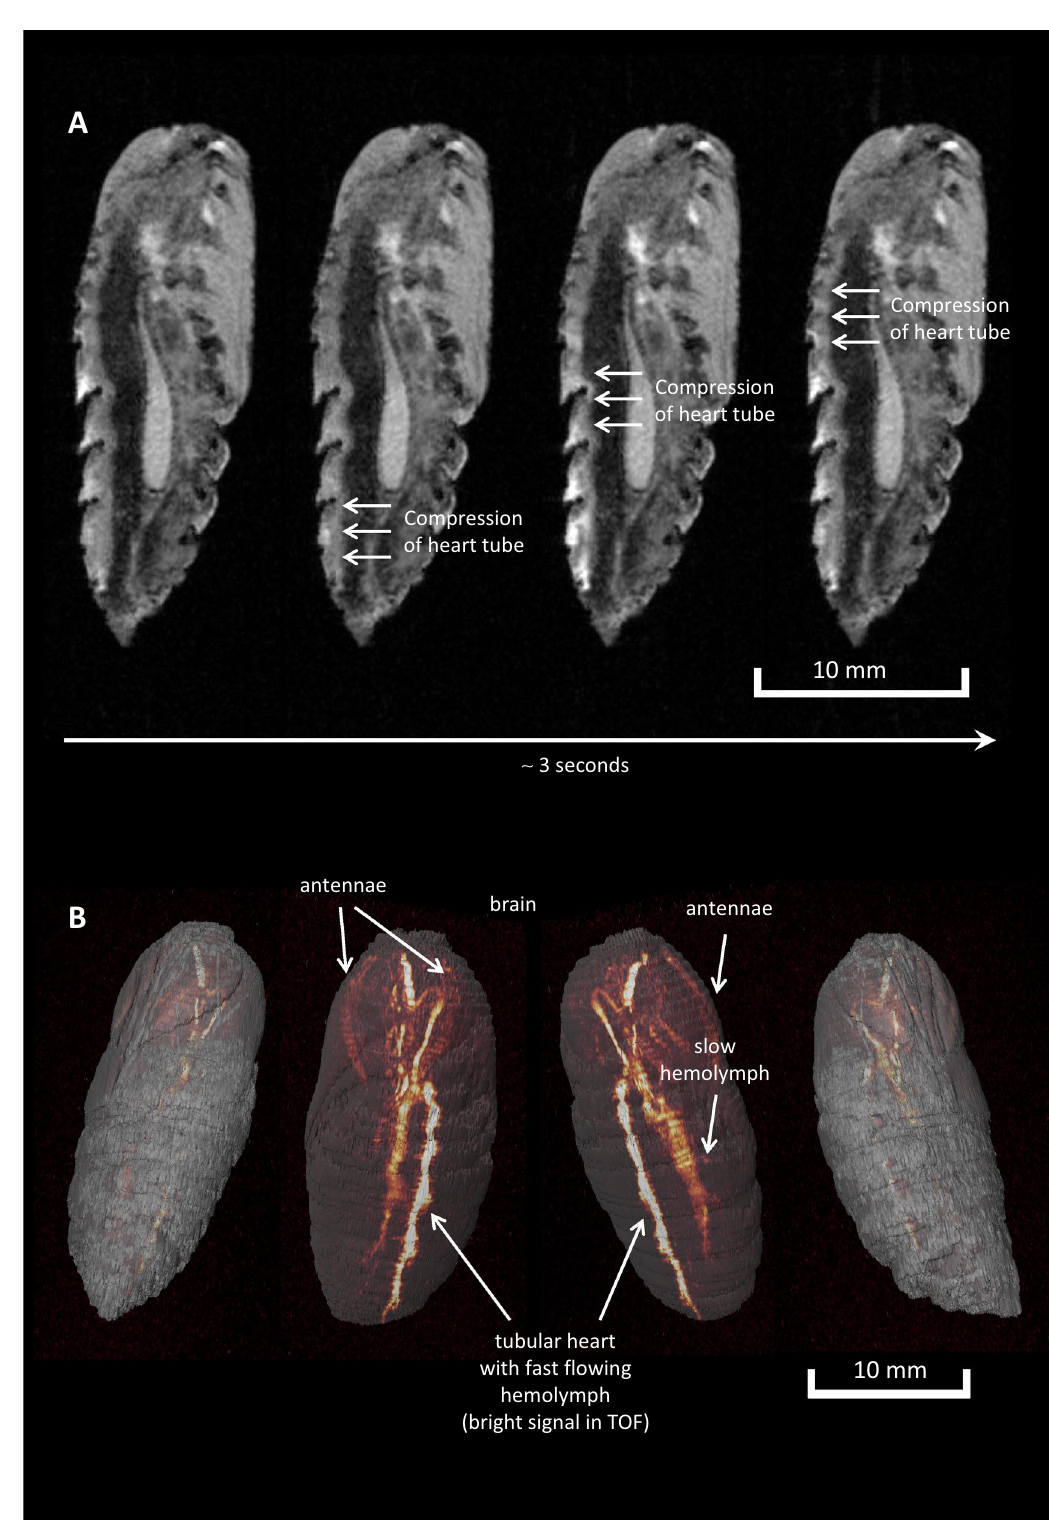
Figure 5. Cardiac contraction and flowing hemolymph. ( A ) Sequential sagittal sections showing successive compression of the heart tube. ( B ) Different views on 3D reconstructed time-of-flight (TOF) MR angiography data illustrating the path of the flowing hemolymph within pupae of S. pavonia